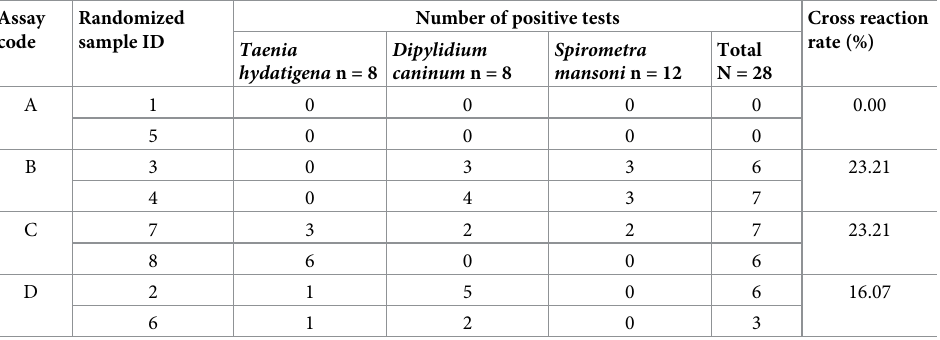
Table 6. Cross-reactivity with other